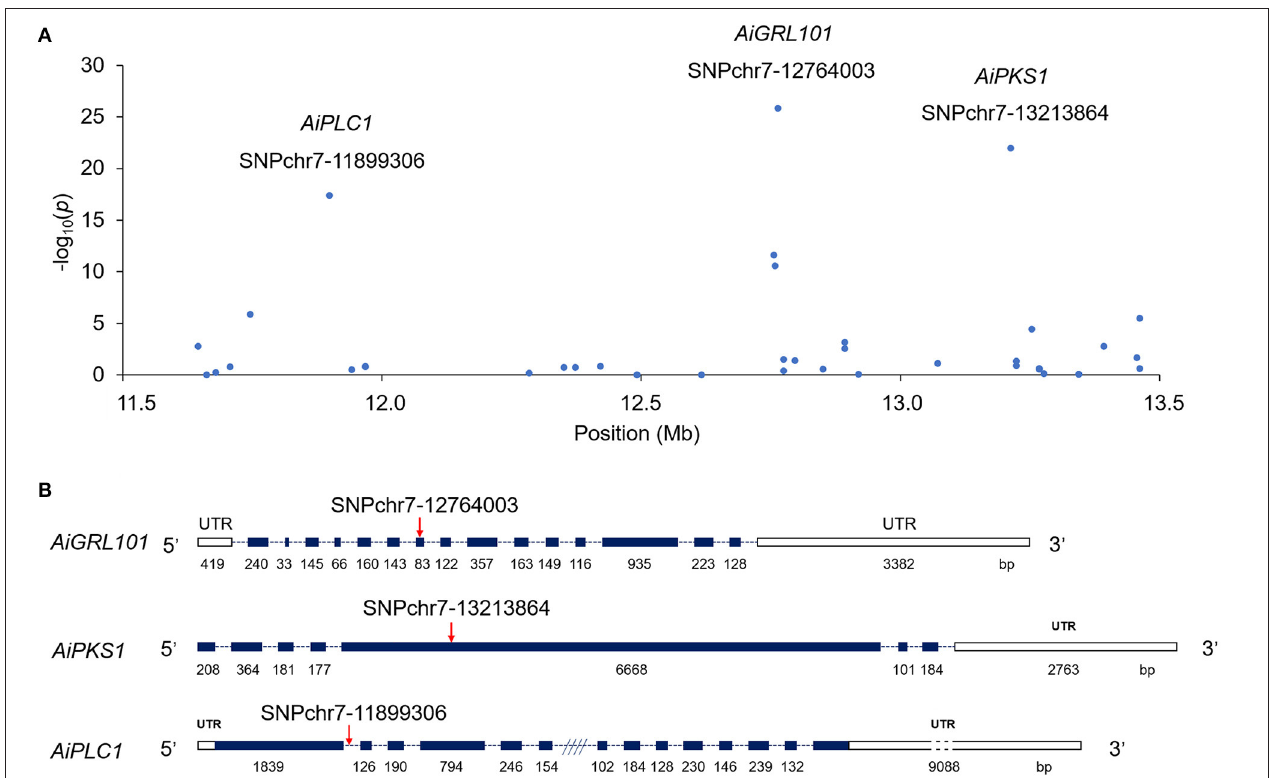
FIGURE 3 | A few neighboring SNP loci on chromosome 7 are independently associated with shell color in the bay scallop. (A) The genic structure of AiGRL101, AiPKS1, and AiPLC1. (B) The blank boxes indicate the 5 ′ UTRs and 3 ′ UTRs (untranslated region); the dark blue boxes represent coding sequence (CDS); the dotted lines indicate the introns; and the red arrows indicate the verified SNPs in responding genes. The CDS are shown relative to their lengths and the SNPs are marked in the accurate positions in the genic sequences.